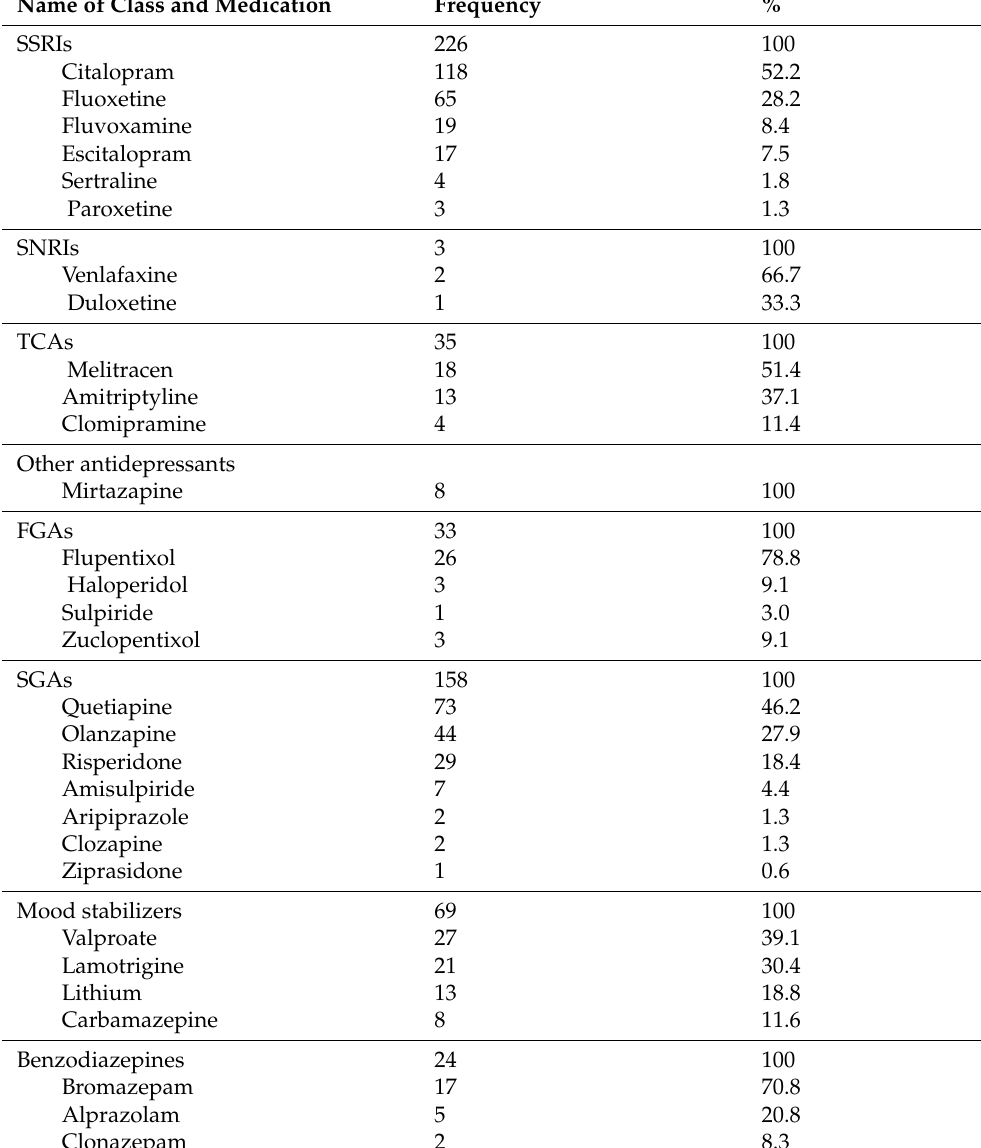
Table 2. Frequency of individual psychotropic